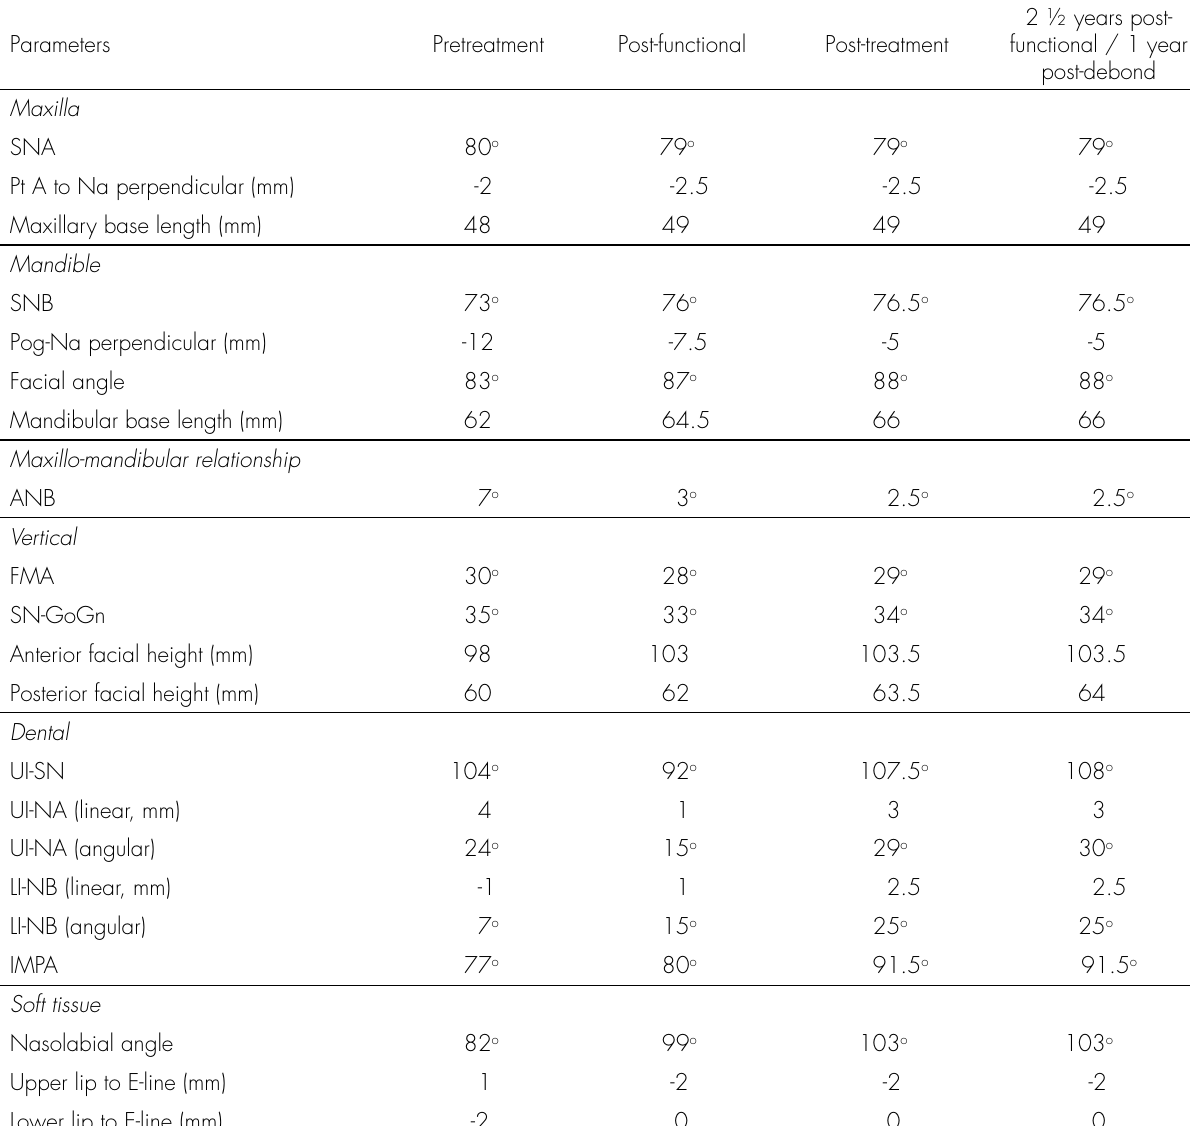
Table I. Measurements of cephalometric